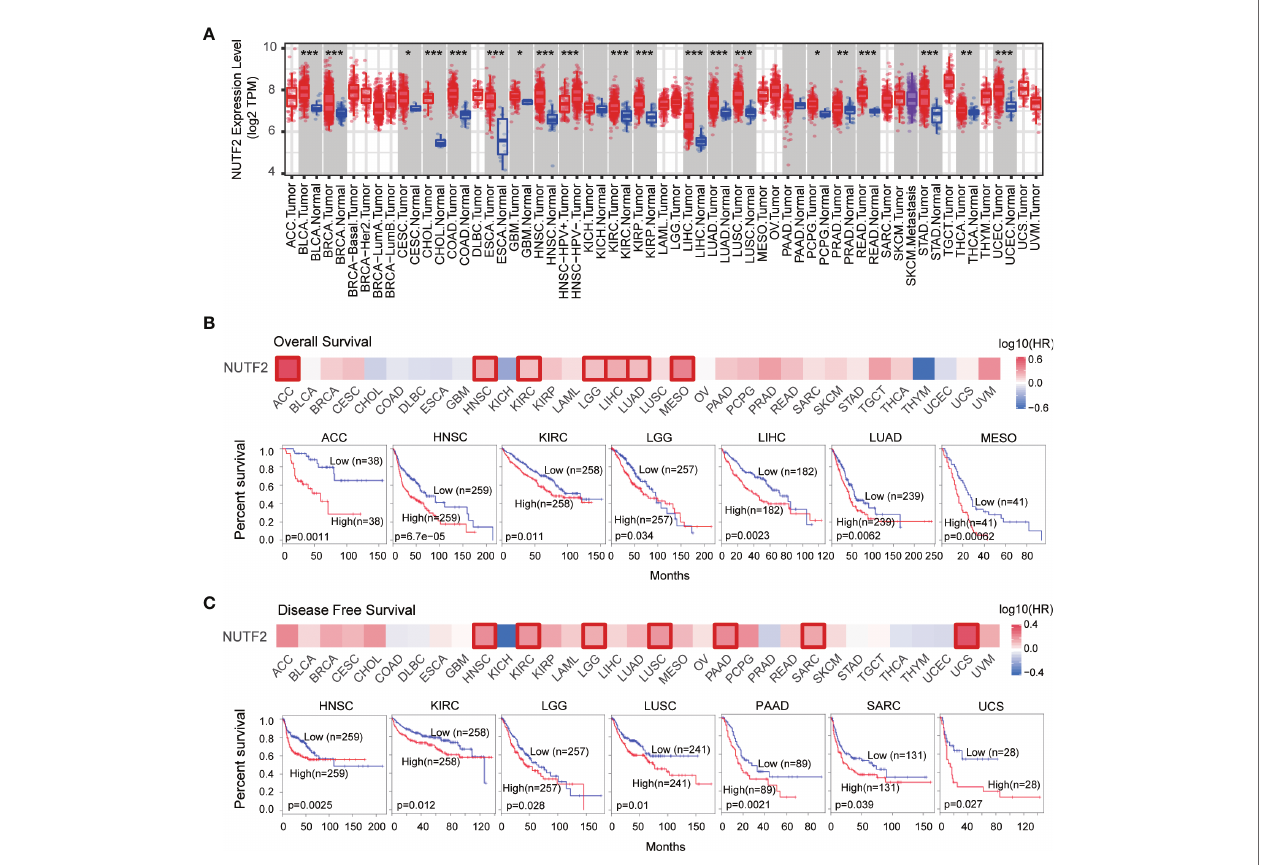
FIGURE 1 | Expression pro fi le and prognostic value of NUTF2 in TCGA cohorts. (A) The expression of NUTF2 in different types of cancers or cancer subtypes was analyzed via the TIMER2.0 online resource. * p < 0.05; ** p < 0.01; *** p < 0.001. (B) Overall survival analysis of NUTF2 across the 33 types of cancers. (C) Disease- free survival of NUTF2 in different cancer